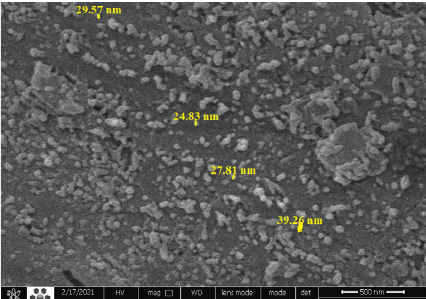
Figure 4: FESEM image of CPAT